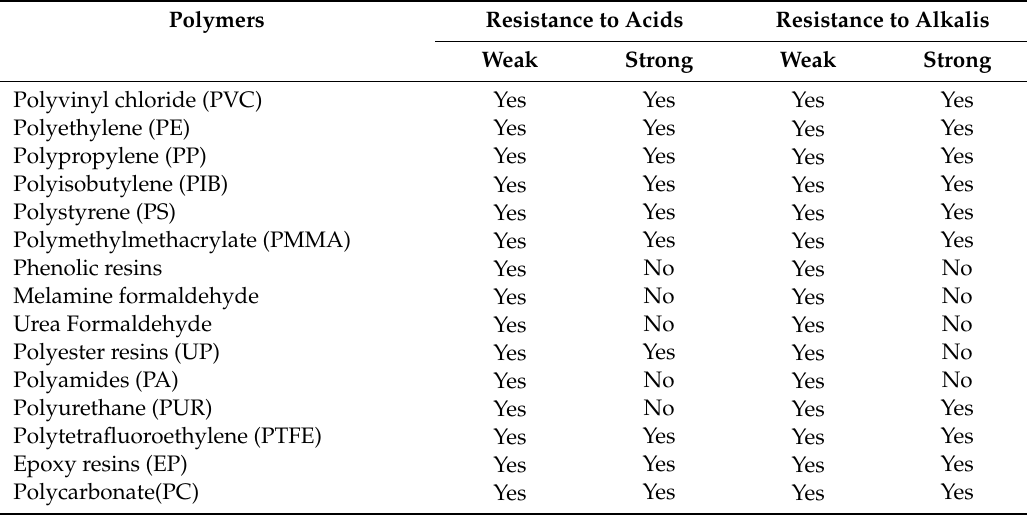
Table 9. E ff ectiveness of agricultural concrete structures